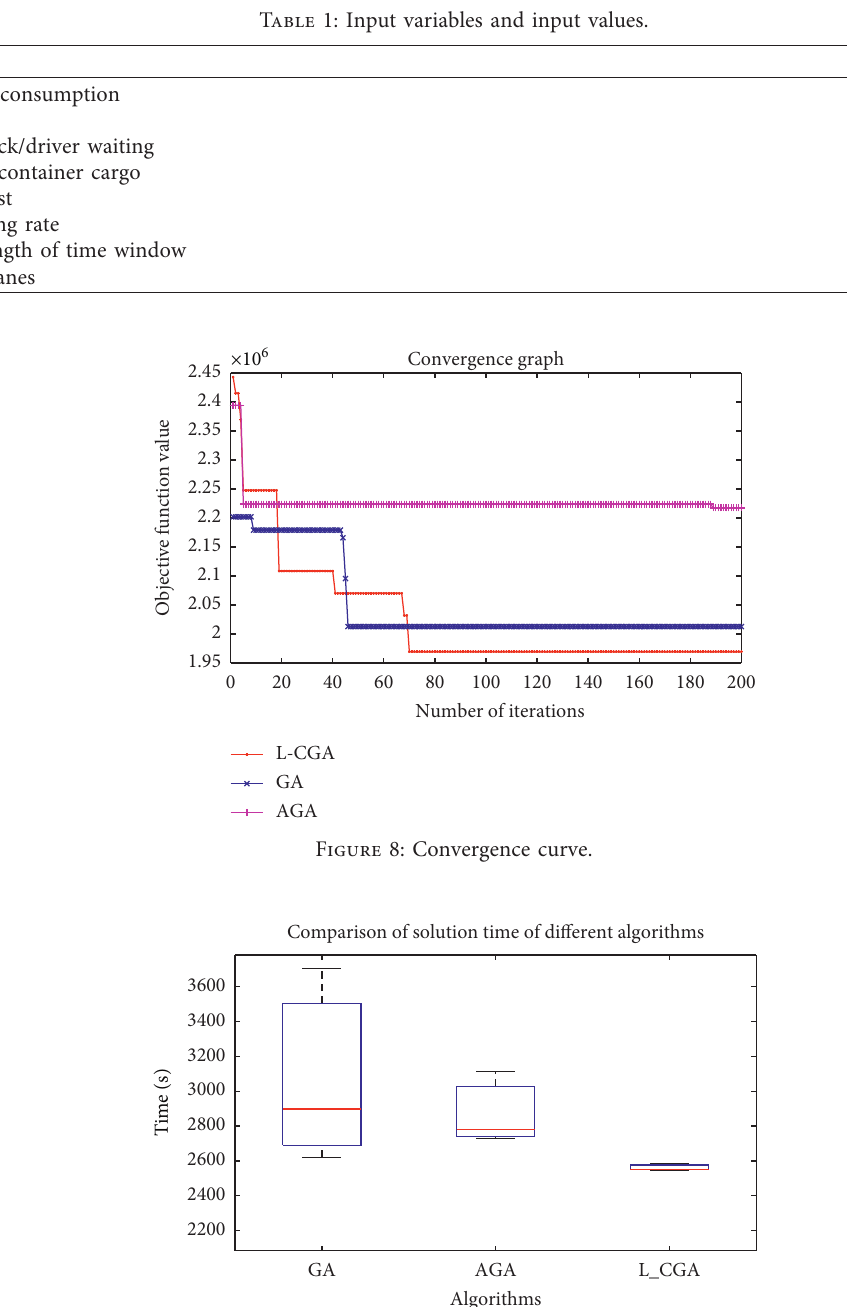
Figure 9: Comparison of solution times of different